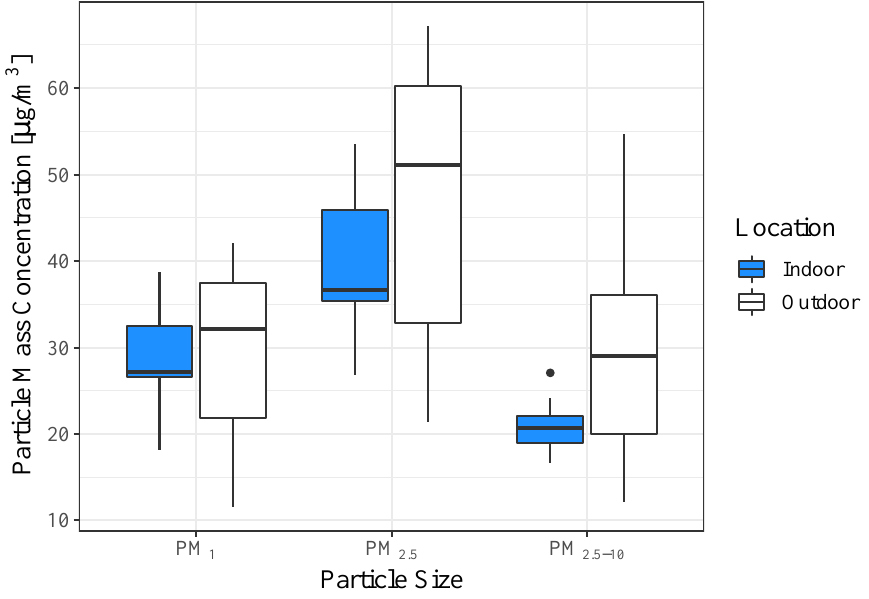
Figure 8. Comparison of indoor and outdoor particle mass concentrations of different size groups.